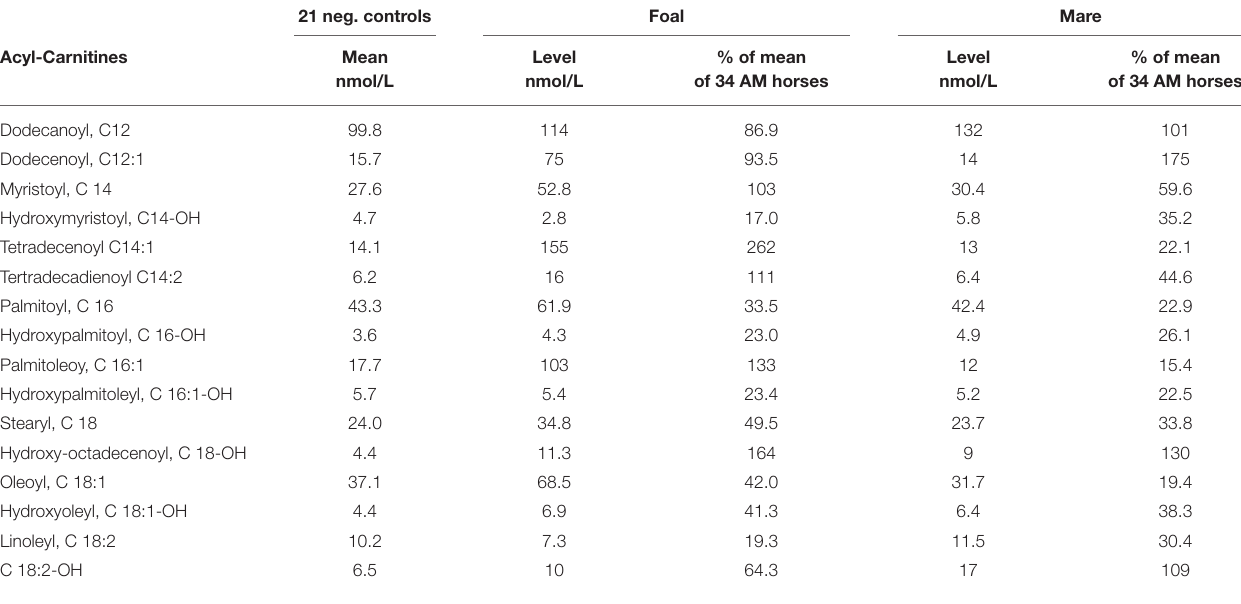
TABLE 3 | Long-chain acylcarnitines, measured by flow-injection MS/MS. 21 neg.